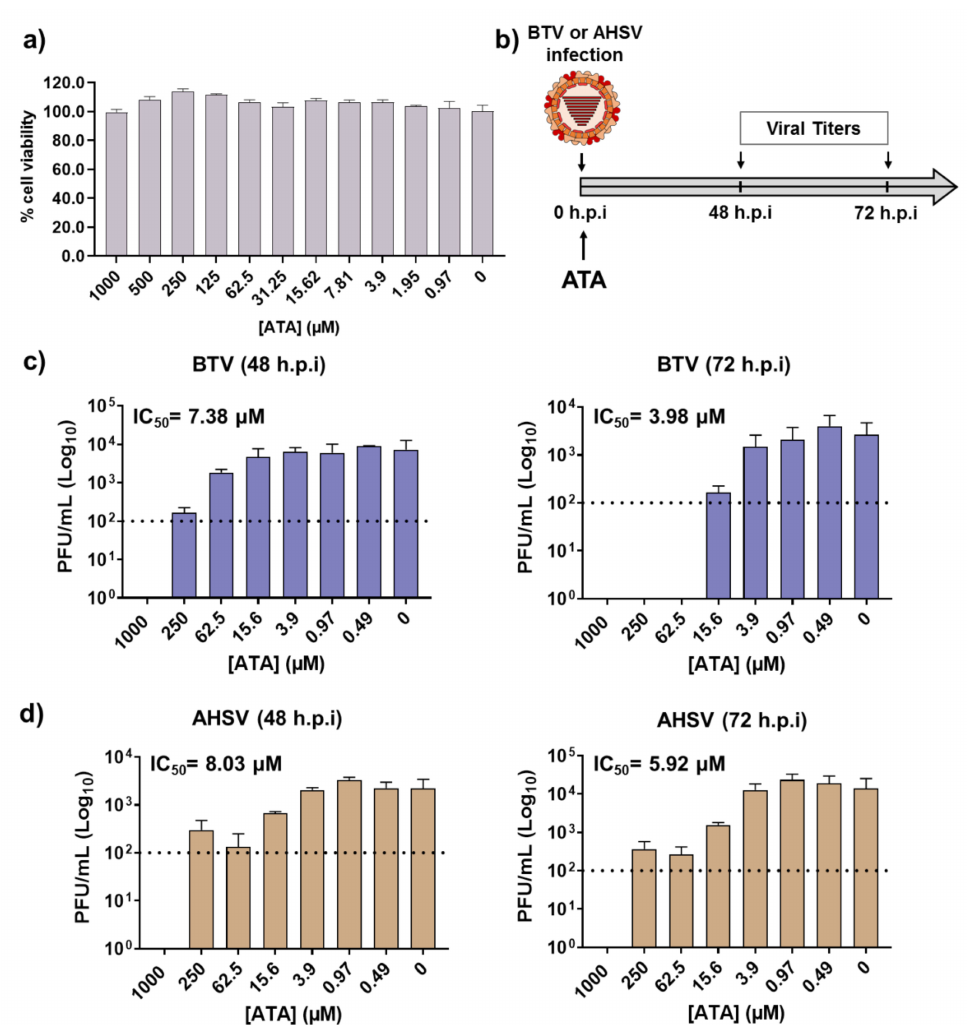
Figure 6. Antiviral activity of ATA in insect KC cells. ( a ) Cytotoxicity of ATA. KC cells were treated with the indicated doses (two-fold dilutions, starting concentration 1000 µ M) of ATA, and cell viability was analyzed. Data are expressed as mean and SD. ( b ) Schematic representation of the experimental design. Cells were infected with BTV-4 ( c ) or AHSV-4 ( d ) at MOI of 0.01 and treated with the indicated concentrations of ATA. At 48 and 72 h.p.i, viral replication was evaluated by the plaque assay. Dotted lines indicate the limit of